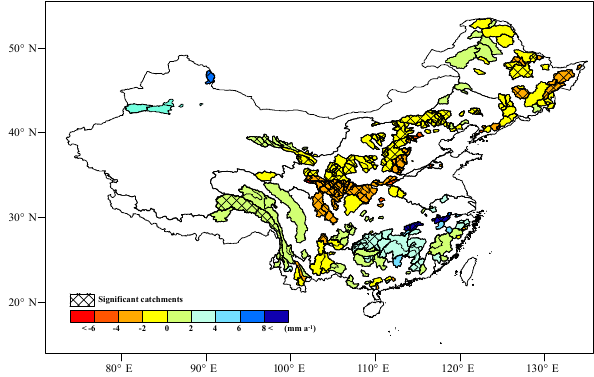
Figure 3. Observed runoff trends ( k Q ) in the 291 catchments for the period 1956–2000. The significant catchments are ones experienc- ing significant changes in runoff at the significance level of